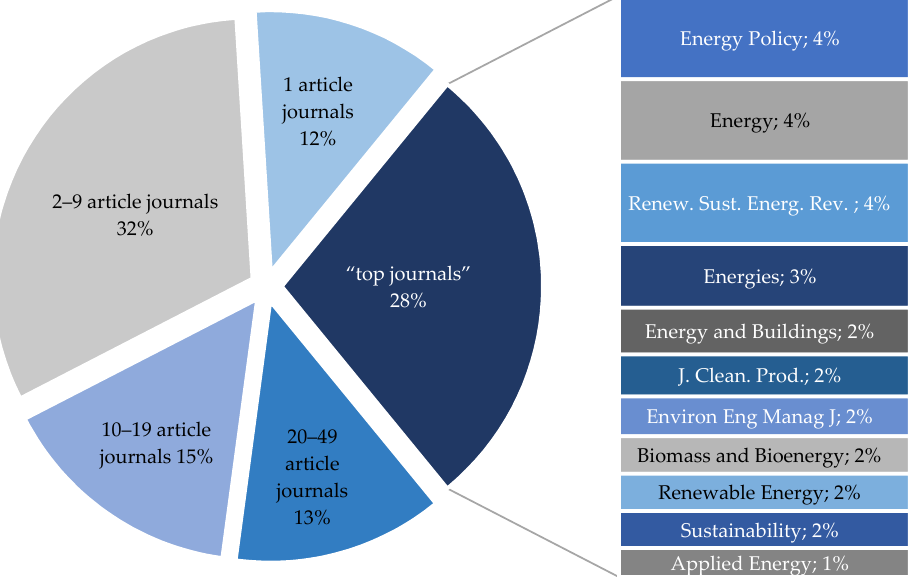
Figure 2. Article distribution across the journals. Source: Authors; N = 3534.